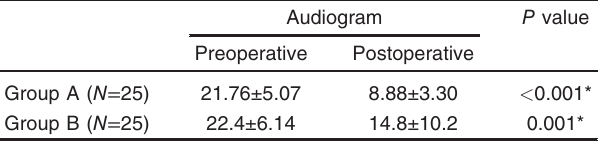
Table 3 Average of preoperative and postoperative air-bone gap (dB)